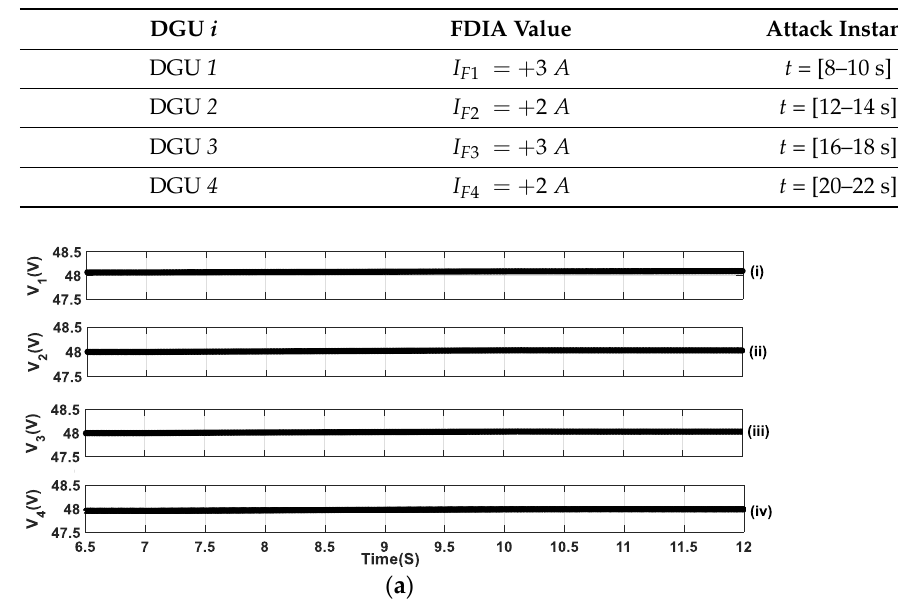
Table 6. Simultaneous current FDIA parameters.